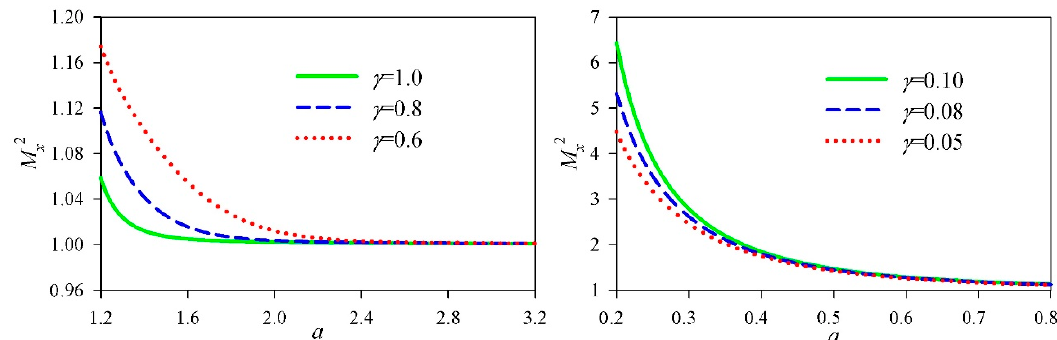
Figure 2. By giving the decay factor a , the M x 2 factor of the cosh-Airy beam as a function of the cosh parameter γ is shown.